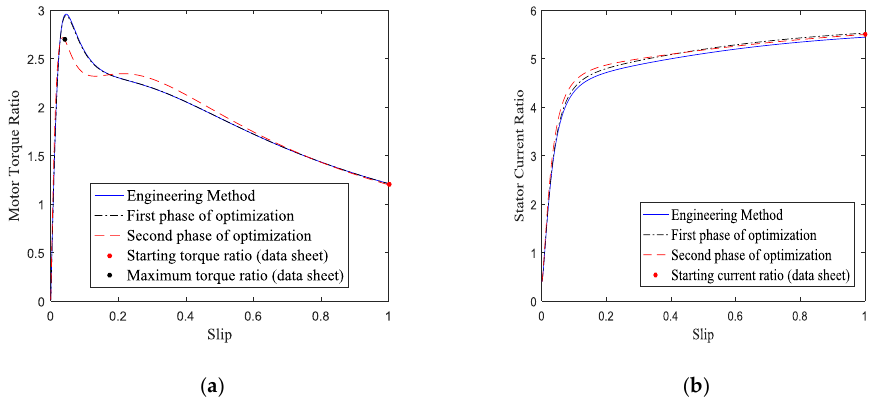
Figure 4. Characteristics of the induction motor number 6 (1LA8 455-8AD): ( a ) Torque-slip, ( b ) Current-slip.